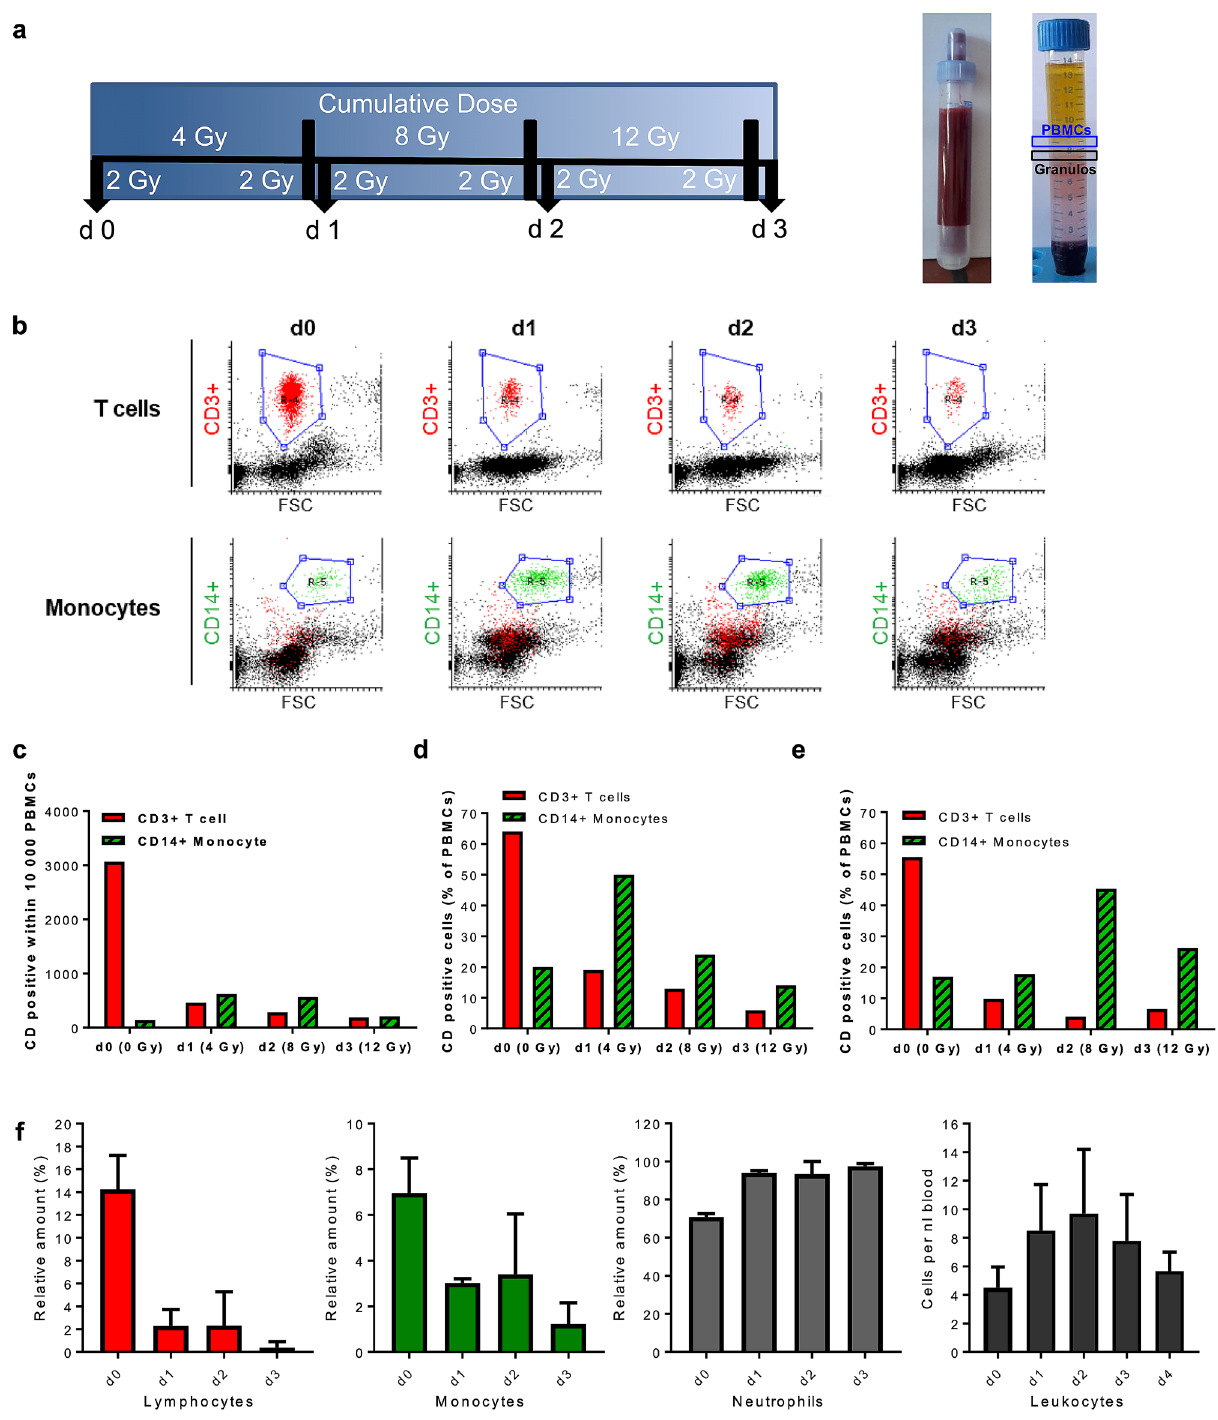
Figure 4. Treatment scheme of leukaemia patients, blood sampling during whole-body irradiation and influence of radiation on the number of T cells (CD3+) and monocytes (CD14+) in peripheral blood following total-body radiation. ( a ) Patients received a cumulative dose of 12 Gy, fractionated in 2 × 2 Gy per day. Blood sampling at day 0 (d0) occurred before the first 2 × 2 Gy fraction was administered (non-irradiated control). Blood samples on d1 and d2 were taken every morning before the patients were treated with further 2 × 2 Gy. The d3 blood sample marks the last day after cumulative 12 Gy of irradiation. Purification of PBMC and granulocytes was performed by polymorphprep™ density centrifugation. ( b ) Blood counts of CD3+ (T cells) and CD14+ (monocytes) cells in the PBMC fraction from one patient determined by flow cytometry. From day zero on, there was a clear decrease of T cells in the peripheral blood. Monocytes show at d1 and d2 a relative increase in the PBMC population. ( c ) Quantification of CD3+ T cells and CD14+ monocytes in PBMC of the patient indicated in ( b ). ( d , e ) Amount of CD3+ T cells and CD14+ monocytes determined in the PBMC samples obtained from two different patients. The determination occurred on stained slides by LSM (100 cells each). The data indicate a time-dependent decrease in the T cell number, while monocytes even displayed an accumulation at d1 and d2. ( f ) Relative amount of lymphocytes, monocytes and neutrophiles and total amount of leukocytes in the peripheral blood of patients during the TBR period. Data obtained from up to 8 patients are pooled and presented as mean +/−